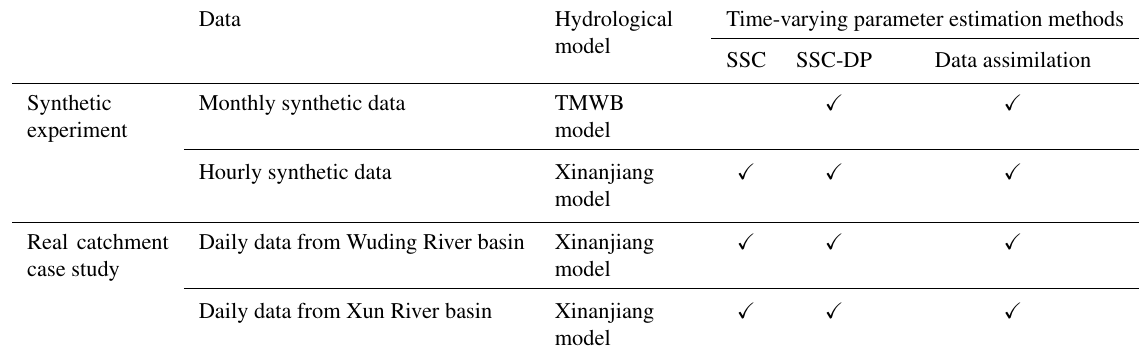
Table 3. Different cases of synthetic experiments and real catchment case studies for comparison and